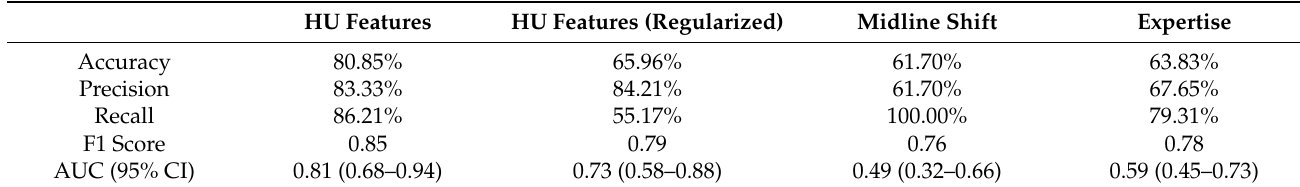
Figure 2. Performance of models based on HU features (original and regularized), midline shift, and clinical expertise in discriminating intracranial hypertension; the AUCs for these models were 0.81, 0.73, 0.49, and 0.59, respectively. Table 2. Performance of models based on HU features (original and regularized), midline shift, and clinical expertise in predicting intracranial hypertension.